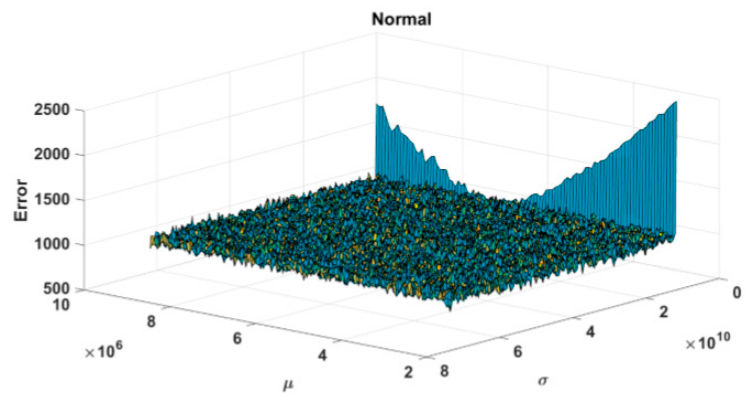
Figure 3. Validation error (Normal).